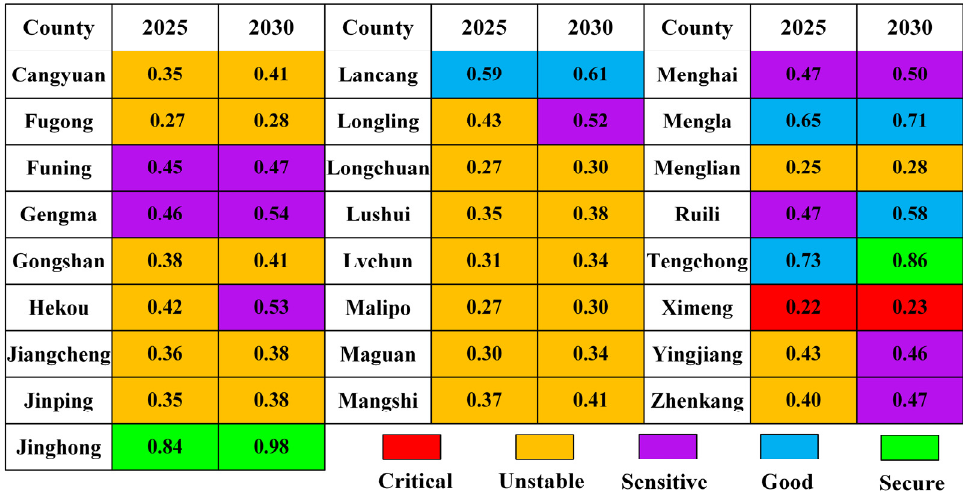
15 of 21 Figure 7. The obstacle degree of each element of ecological security in 25 border counties in Yunnan Province, China for economic, social, environmental, landscape pattern, ecosystem service value (ESV). Note: 04 and 19 indicate the years of 2004 and 2019, respectively. 4.4. Prediction of Changes in ES for the Period 2025–2030 According to the respective ES level of each border county from 2004 to 2019, pre- dicted values for ES in 2025 and 2030 were obtained (Figure 8). The ES of border areas is predicted to maintain an upward trend. In 2025, Jinghong would first reach a secure state; Lancang, Mengla, and Tengchong would reach a good state; and Menghai, Ruili, Gengma